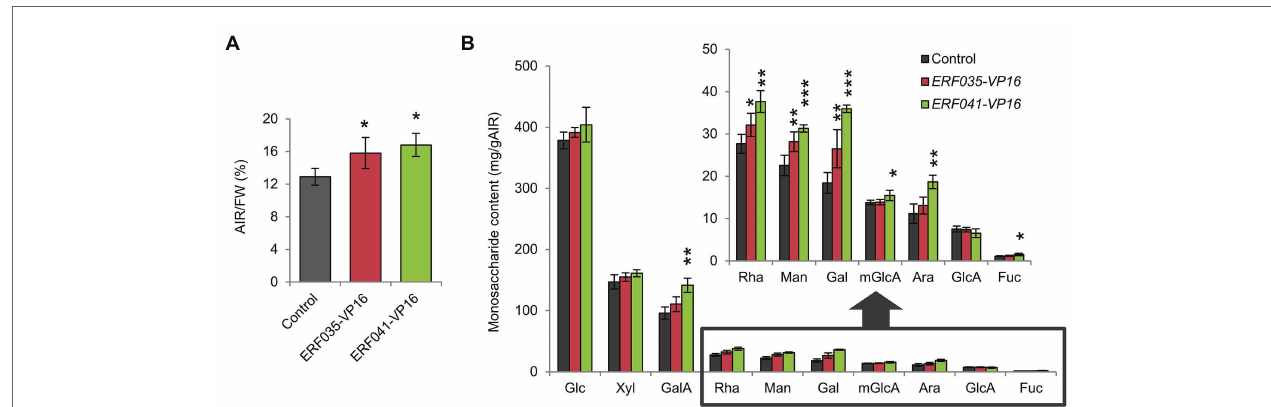
FIGURE 3 | Quantitative analysis of cell wall residues and cell wall-derived monosaccharides. (A) Cell wall contents of inflorescence stems as alcohol insoluble residues (AIRs) per fresh weight (FW; AIR/FW). (B) Monosaccharide content of individual cell wall samples. Glc, D-glucose; Xyl, D-xylose; GalA, D-galacturonic acid; Rha, L-rhamnose; Man, D-mannose; Gal, D-galactose; mGlcA, 4- O -methyl-D-glucuronic acid; Ara, L-arabinose; GlcA, D-glucuronic acid; and Fuc, L-fucose. Data represent mean ± SD performed by biological quadruplicates. * p < 0.05, ** p < 0.01, and *** p < 0.001 by Dunnett’s